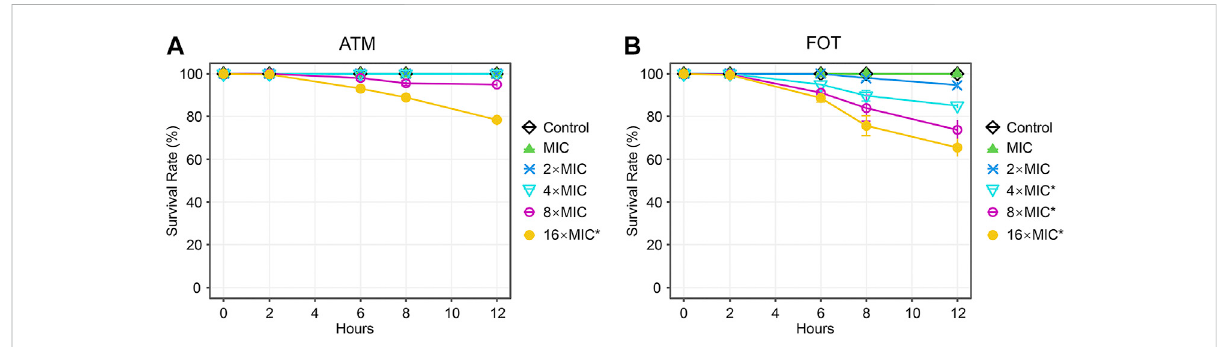
FIGURE 3 Time curve analyses of the toxicity of different concentrations of antibiotics in C. elegans. Time curves were used to evaluate the time- dependent changes in the survival in C. elegans treated with different concentrations of (A) ATM, (B) FOT. Results are expressed as mean ± SD. Asterisks represent the signi fi cance of the difference in survival between the antibiotic-treated group and control group ( p <